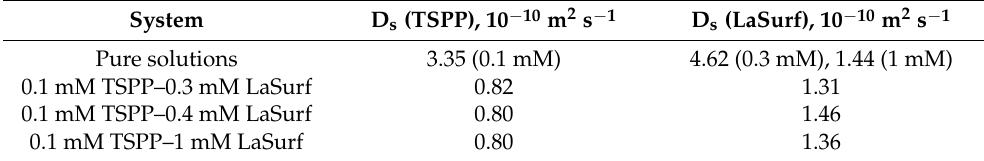
Table 1. Self-diffusion coefficient (D s ) values for pure TSPP and LaSurf and their mixtures in D 2 O, 300